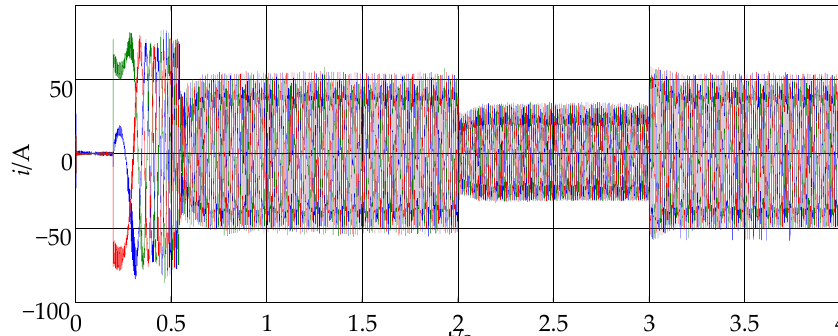
Figure 10. Three-phase stator current waveform.